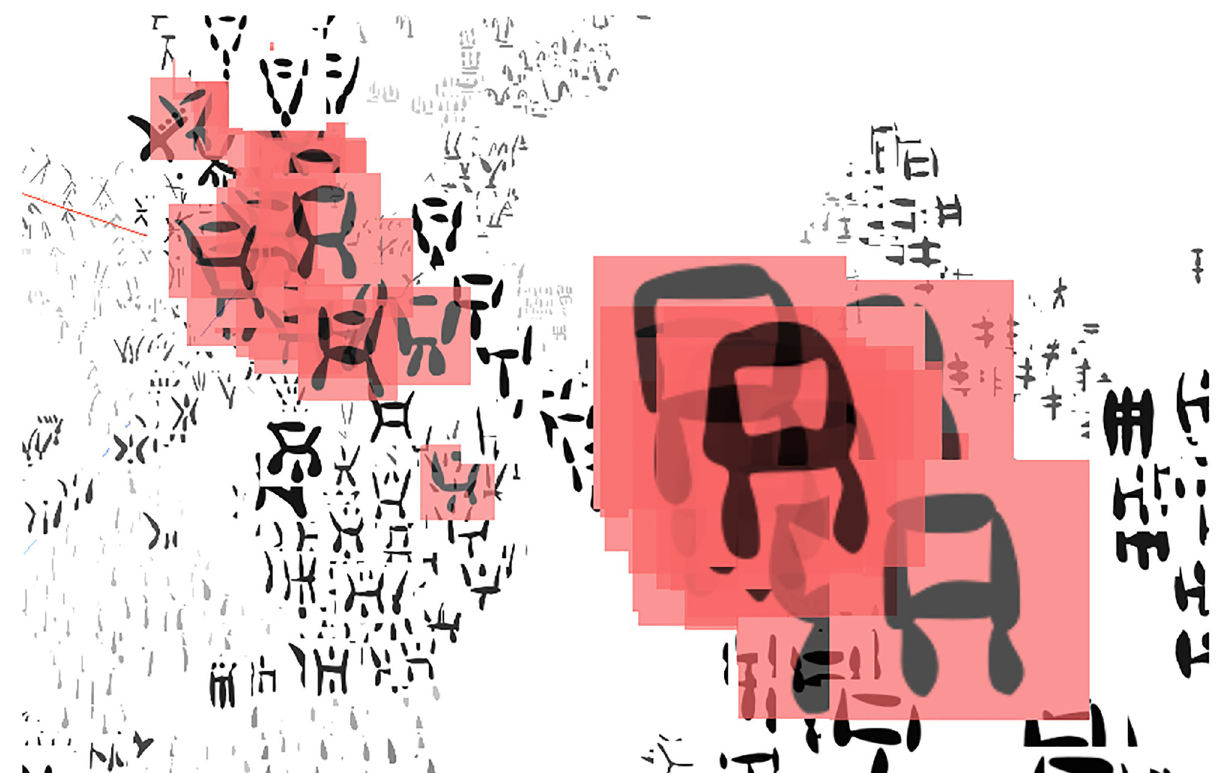
Fig 7. Separation of a CM grapheme in two groups in the 3D scatter plot. Example of sign 097.